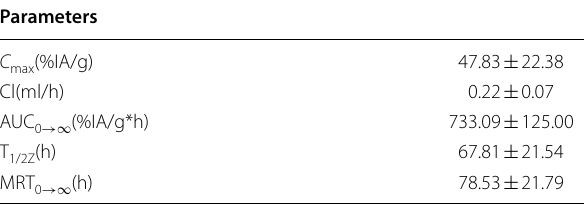
Table 1 Pharmacokinetic parameters of 131 I-PD-L1-mAb